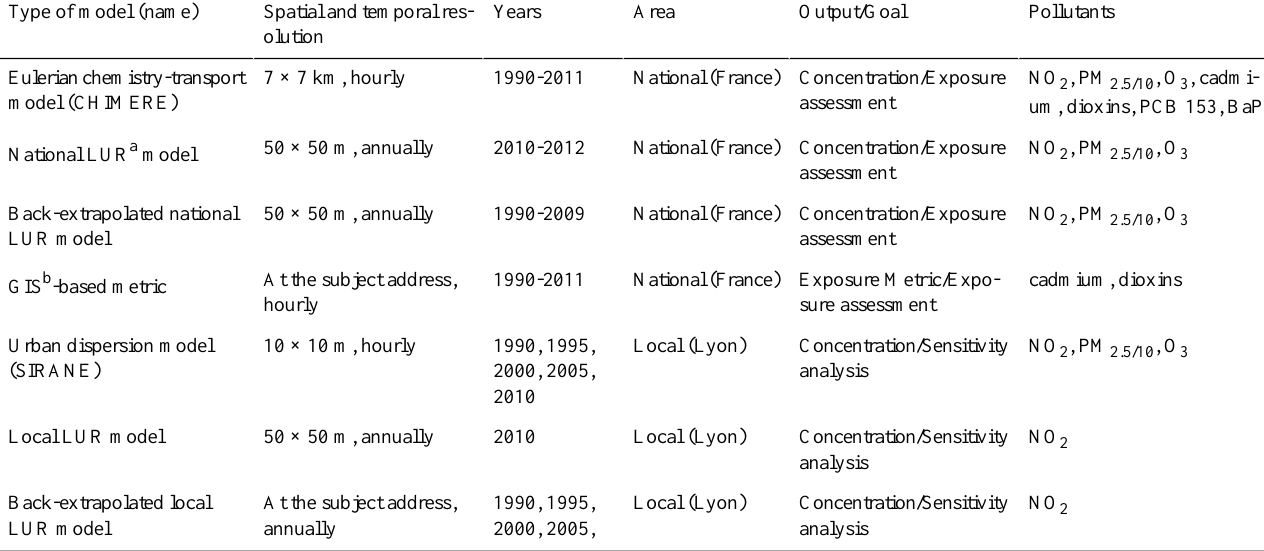
Table 1. Summary of the models used to assess atmospheric exposure. PollutantsOutput/GoalAreaYearsSpatial and temporal res- olutionType of model